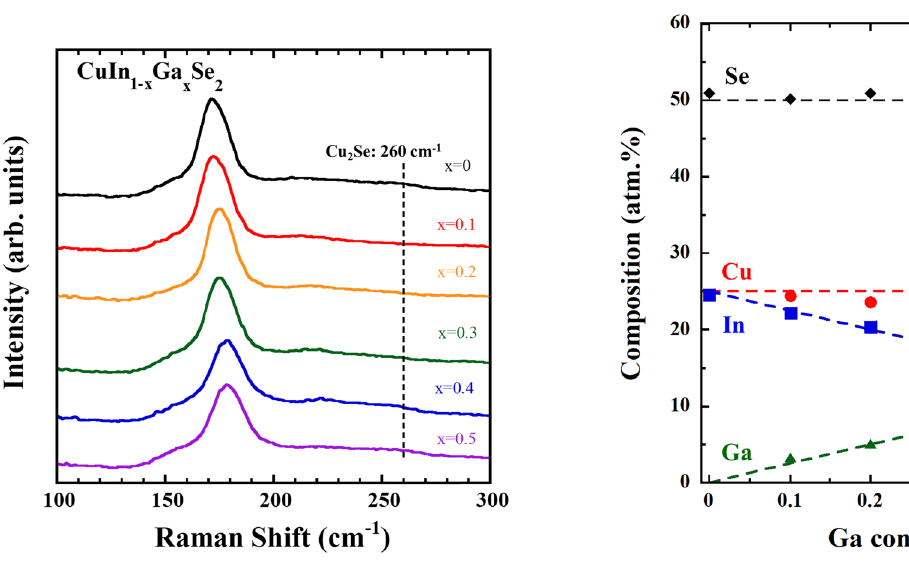
Figure 4: Average compositions of each CIGS single crystal wafer ( Ga content x = 0 – 0.5 ) by EDS